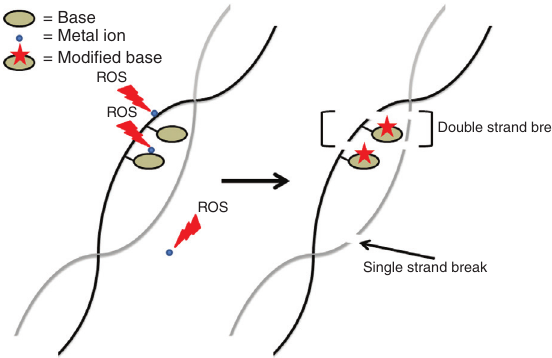
Figure 3 Illustration of ROS formation and oxidative DNA damage from metal ions free in solution and metal ions bound to the phos- phate backbone and individual bases.